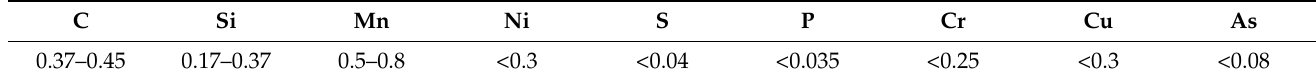
Table 3. Chemical composition of steel 40, wt